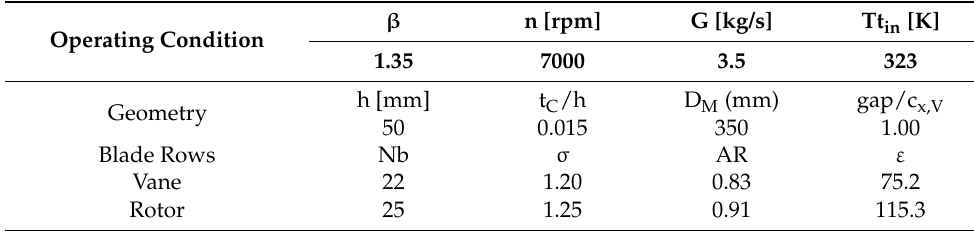
Table 1. Stage geometry and operating conditions.